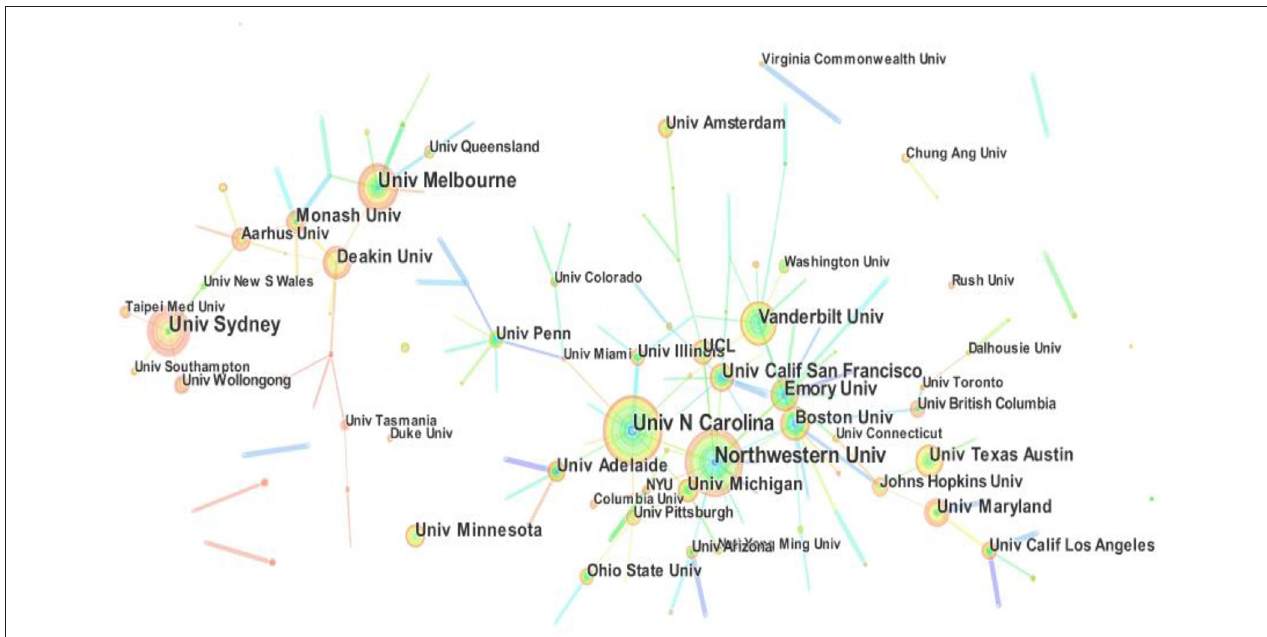
FIGURE 4 | Visualization on main research institutes in health literacy research.